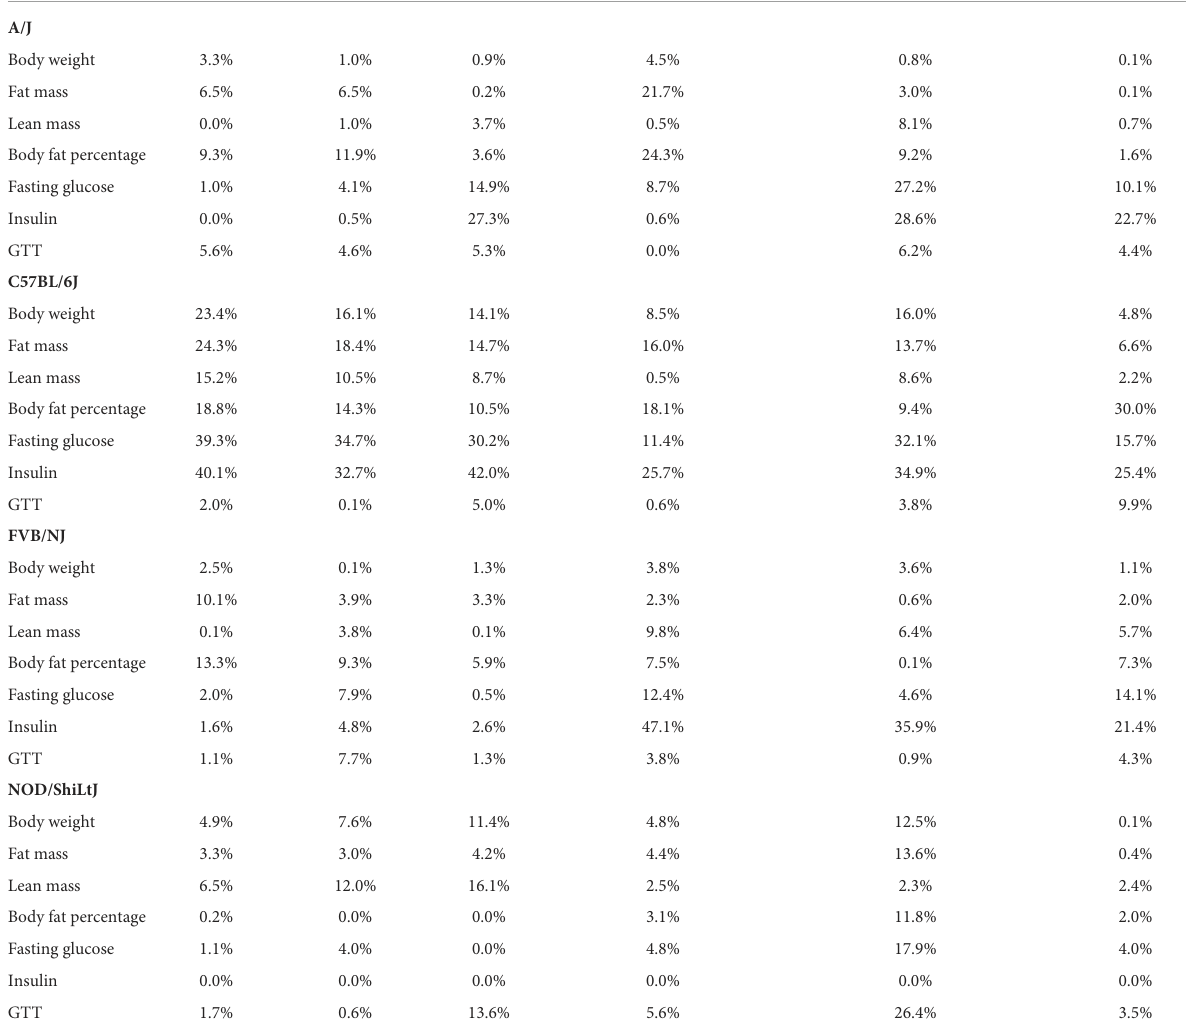
TABLE 2 Percent phenotypic variance explained by gut microbial alpha and beta diversity measures in each of the mouse